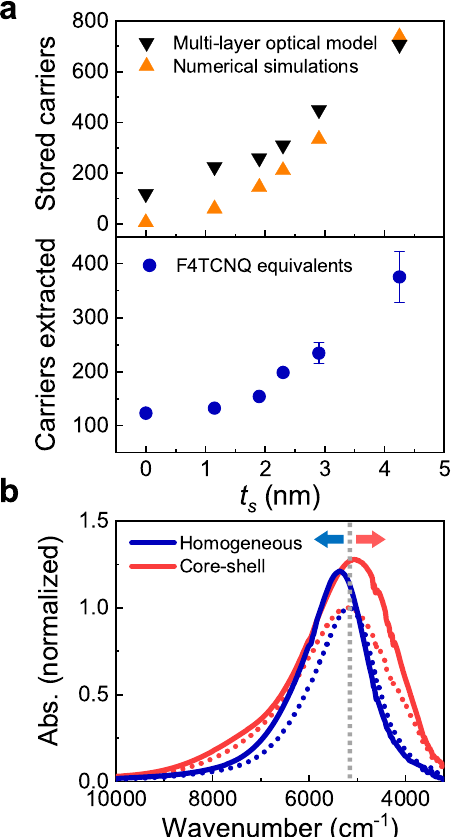
Fig. 4 Charge storage enhancement through depletion layer engineering. a Upper panel: Photoelectrons stored in the NCs as a function of the shell thickness, showing the Δ N e (cid:5) t s 3 trend for values extracted from the empirical multi-layer model (black curve) and the numerical simulations (orange curve). Bottom Panel: Number of electrons extracted via chemical titration using F4TCNQ molecules as a function of t s . The error bars represent the lower and upper limit of the charges extracted within the uncertainty of the data. b Experimental comparison between the optical response of two samples with same size and doping concentrations but different electronic structure, before (dotted line) and after (solid line) photodoping (homogeneous ITO in blue, core – shell ITO-In 2 O 3 in red). The sensitivity of the LSPR modulation via photodoping is enhanced in the core – shell case. We highlight that the peak position of the LSPR after photodoping blueshifts in the homogeneous case, while it redshifts in the core – shell case indicating that depletion layer modulation is the main process of photodoping (see discussion